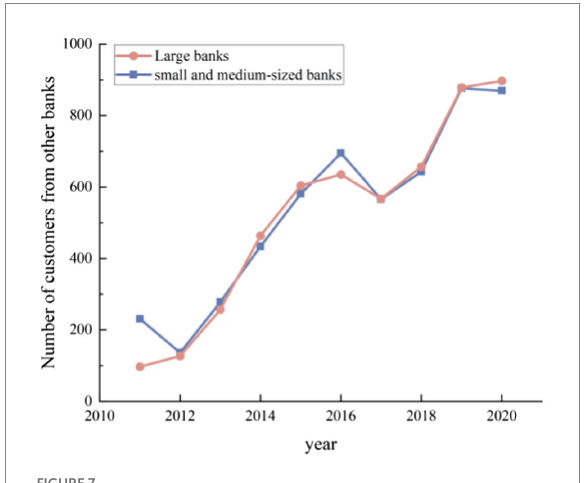
FIGURE 7 Number of customers from other types of banks among new.